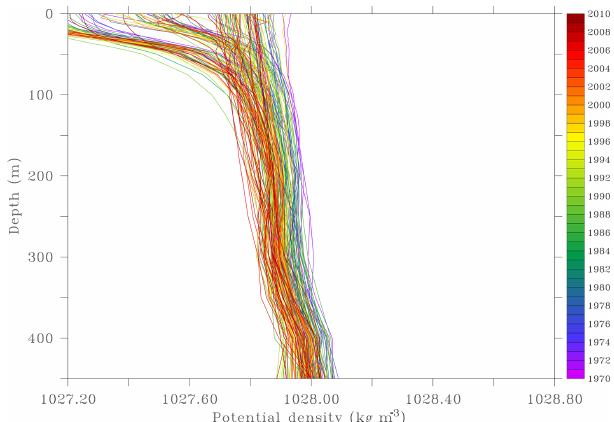
Figure 11. Volumetric salinity classes ranging from 34.4 to 35.2 in the most reliable area per season between 1970 and 2010.